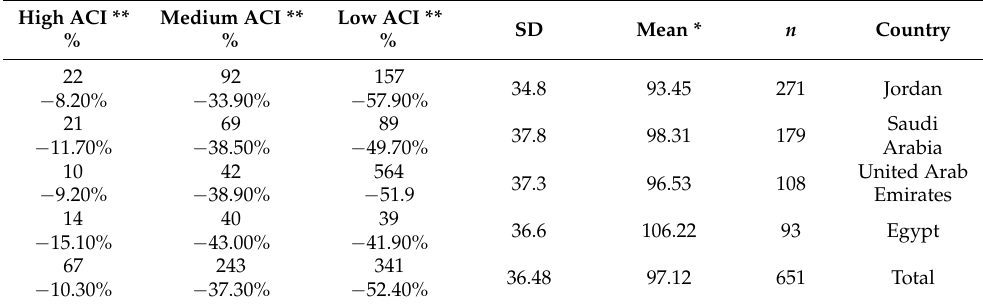
Table 1. Means, standard deviations, and percentages of anxiety about COVID-19 infection by country.